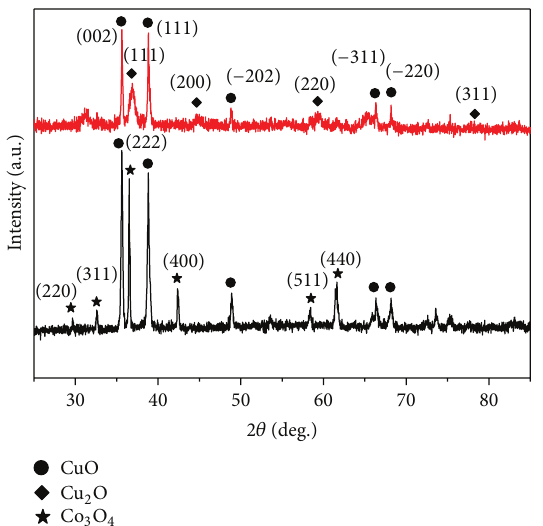
Figure 4: XRD patterns of as-prepared CuO NRs and CuO/Co 3 O 4 coaxial heterostructures.